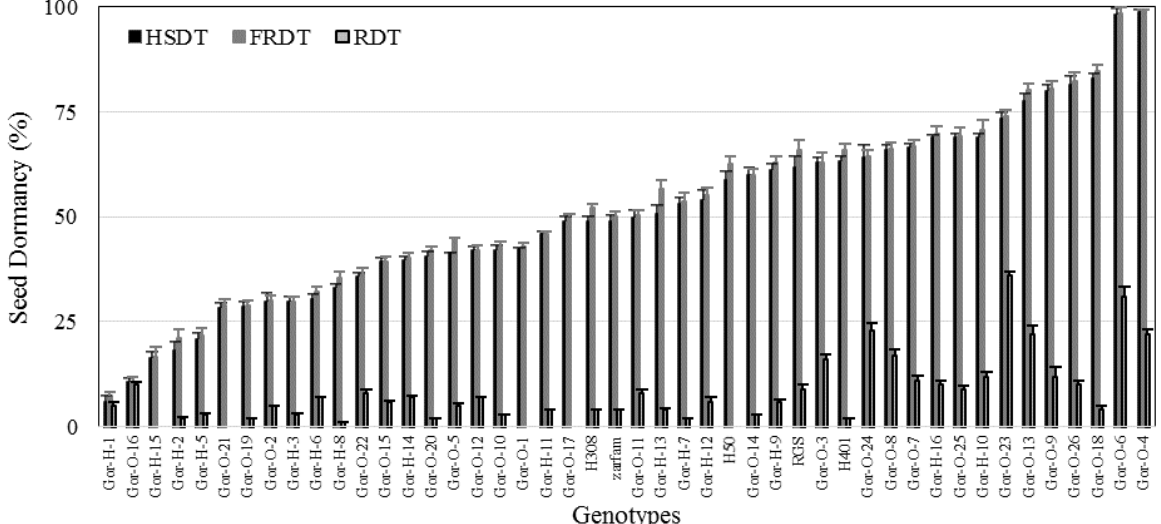
Fig. 2. Levels of secondary dormancy were determined in the seeds from 41 rapeseed lines and 5 cultivars according to HSDT, RDT, and FRDT methods. Significant differences in all lines and cultivars were shown by the standard error.